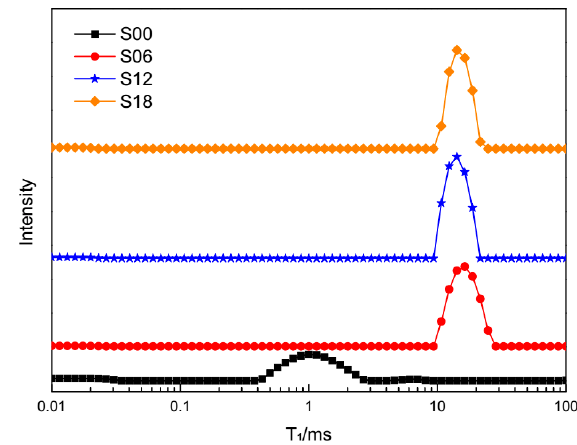
Figure 3. T 1 relaxometry of different cement pastes at 10 min.